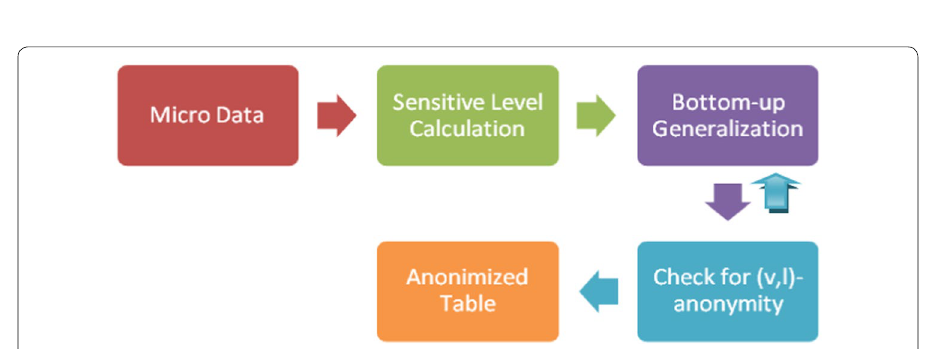
Fig. 1 Overall process of privacy